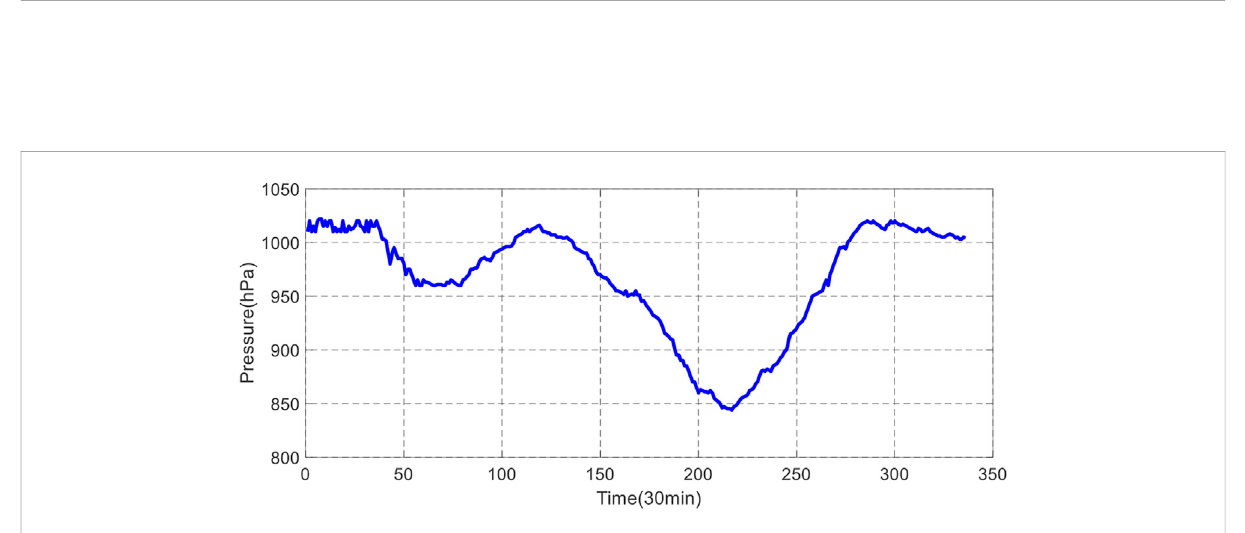
FIGURE 13 Pressure pro fi le (7 days).